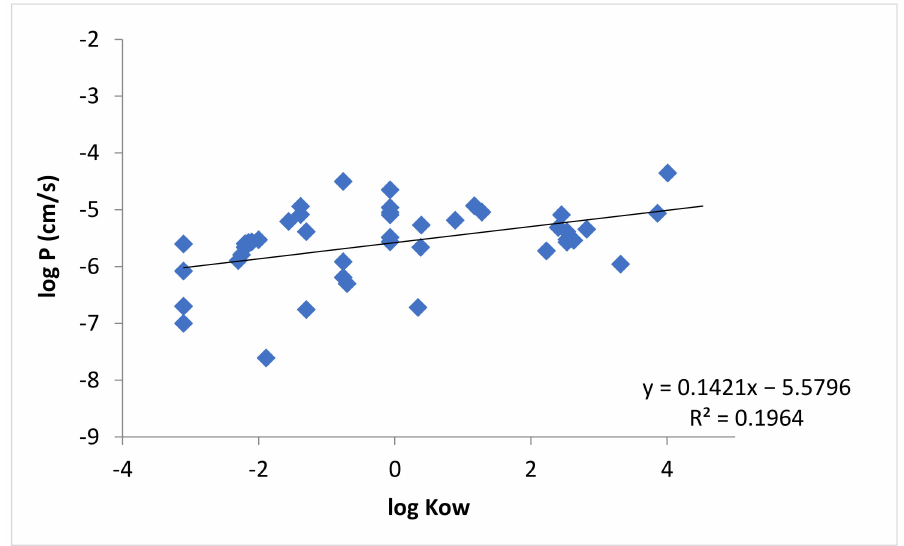
Figure 5. Relationship between log P and log K ow for permeants that are not affected by pH ionization (pH independent permeants) in Table